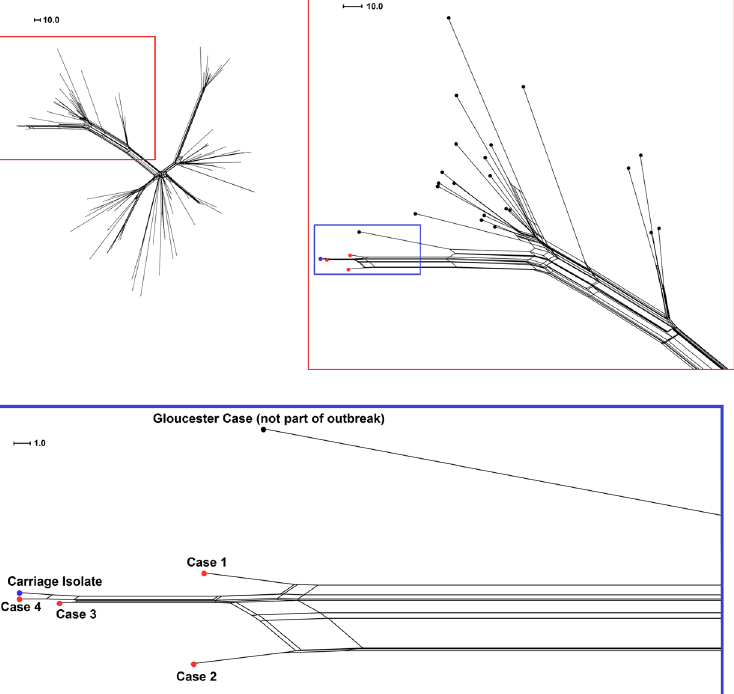
Figure 2. Neighbor-net phylogenetic network of outbreak strains among sub-lineage of the ST-41/44 complex. Genomic analyses were performed at 1546 loci and included a sub-lineage of ST-41/44 complex meningococcal genomes including the four case isolates and a carriage isolate (n = 102: UK = 100 and Ireland = 2). Top left: The network of all selected strains. Top right: zoomed section of network corresponding to area within the red box on opposite image. Below: Further zoomed section of network corresponding to the area within the blue box in the top right image. Outbreak strains, the carriage isolate (swab 5) and a closely-related strain from an unconnected disease case are labelled and highlighted in red, blue and black,